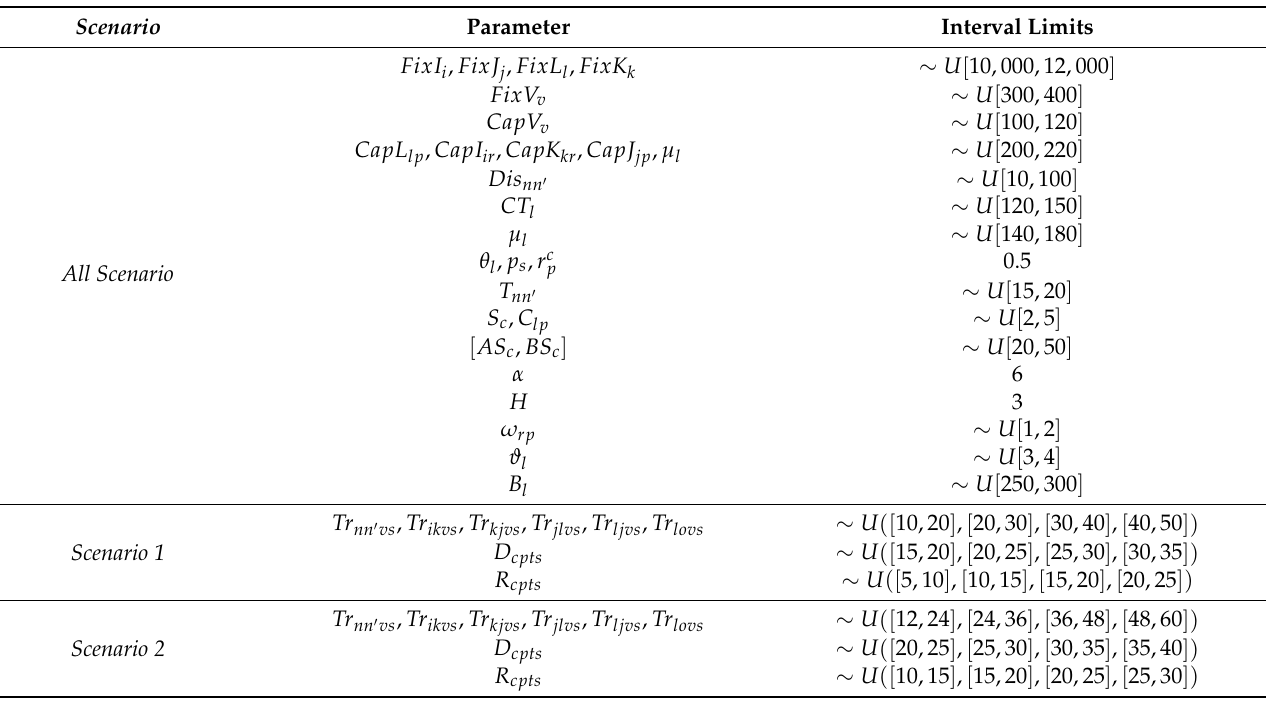
Table 2. The value of parameters.